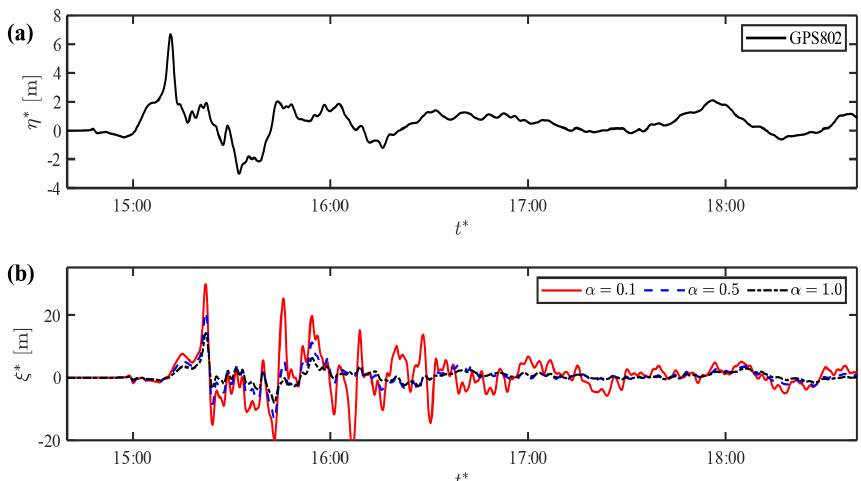
Figure 10. Prediction of shoreline motions in Case 2: (a) observed-wave data at GP802 and (b) predicted shoreline motion based on GPS802.